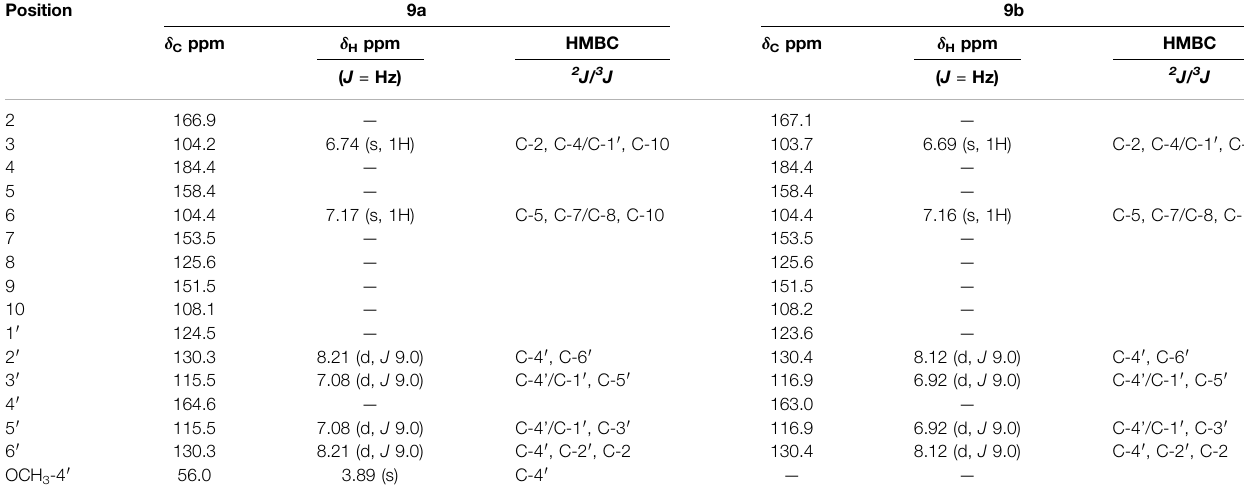
TABLE 2 | NMR data for compounds Beltraonin ( 9a) and Paniculatumin (9b) (500 and 125 MHz, CD 3 OD).